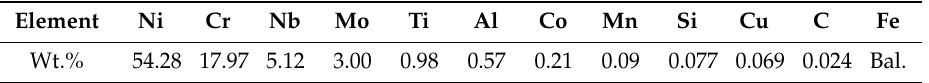
Table 1. The chemical composition of the plasma rotation electrode process (PREP)-processed Inconel 718 powder.